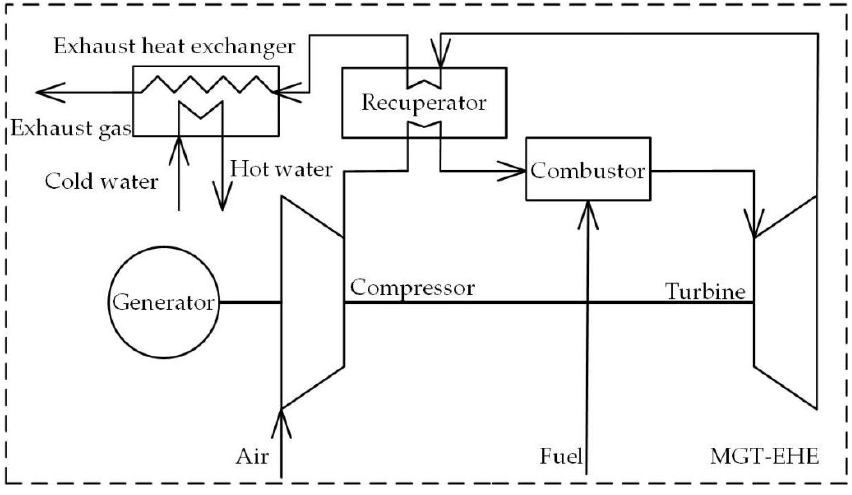
Figure 1. Flow chart of recuperative cycle micro gas turbine system.